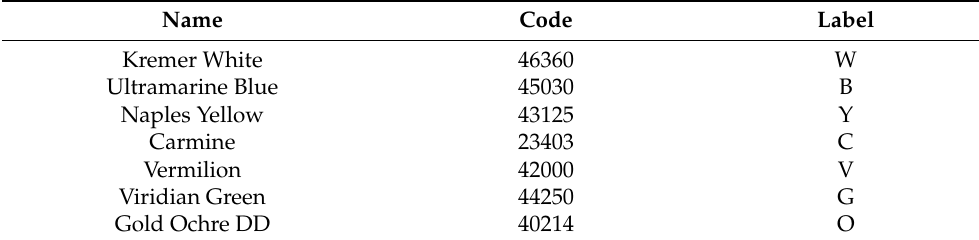
Table 2. Pigments included in the set of mockups. The codes refer to the serial number assigned by the manufacturer. The labels identify the pigments and are arbitrarily assigned to better understand the results when the mockup painting is analysed.